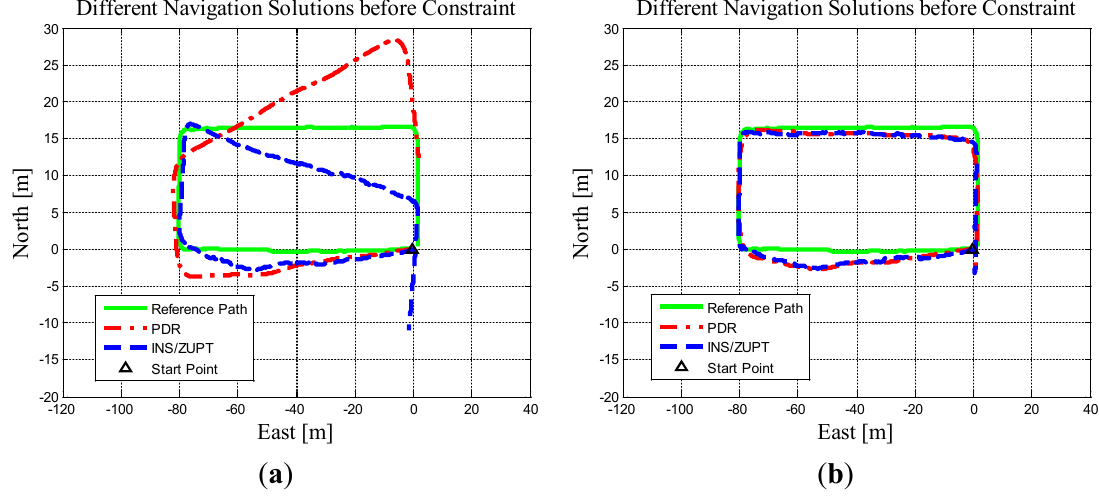
Figure 11. Trajectory IV: Two systems’ navigation solutions. ( a ) Before constraint; ( b ) After constraint.